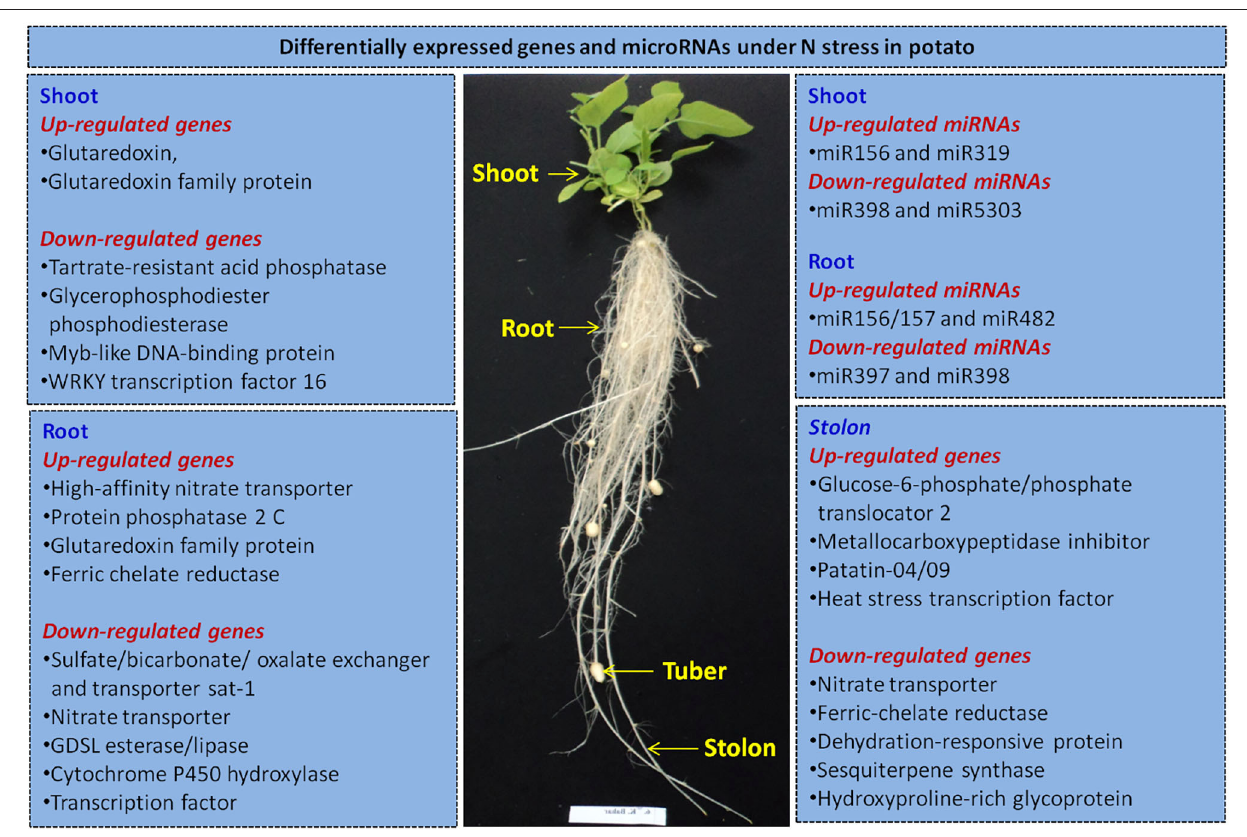
FIGURE 1 | An outline of selected differentially expressed genes identified in potato under N stress based on transcriptome (RNA-seq and small RNA) sequencing of plant grown in aeroponic culture (Tiwari et al., 2020a,b,c). It summarizes the potential candidate genes, transcription factors and microRNAs in different potato tissues (root, shoot/leaf, and stolon) for improving nitrogen use efficiency in potato by gene manipulation via transgenics and/or CRISPR/Cas9 genome editing coupled with based-editing technologies.